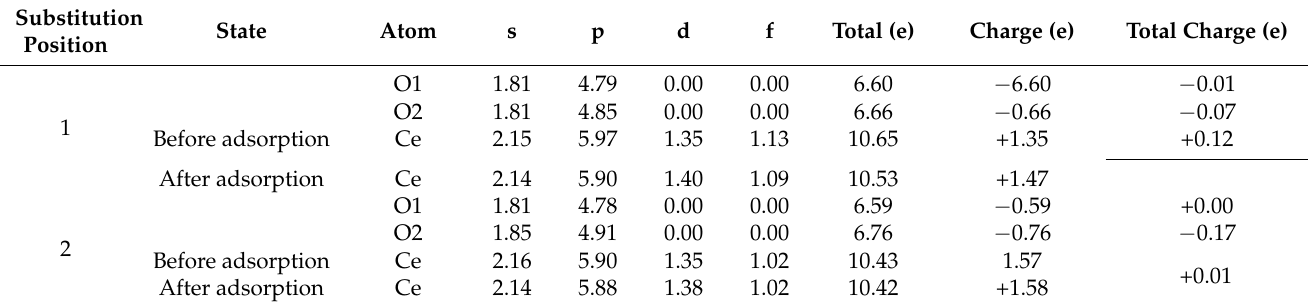
Table 6. The Mulliken population analysis of NHA on the bastnaesite (100) surface after adsorp- tion